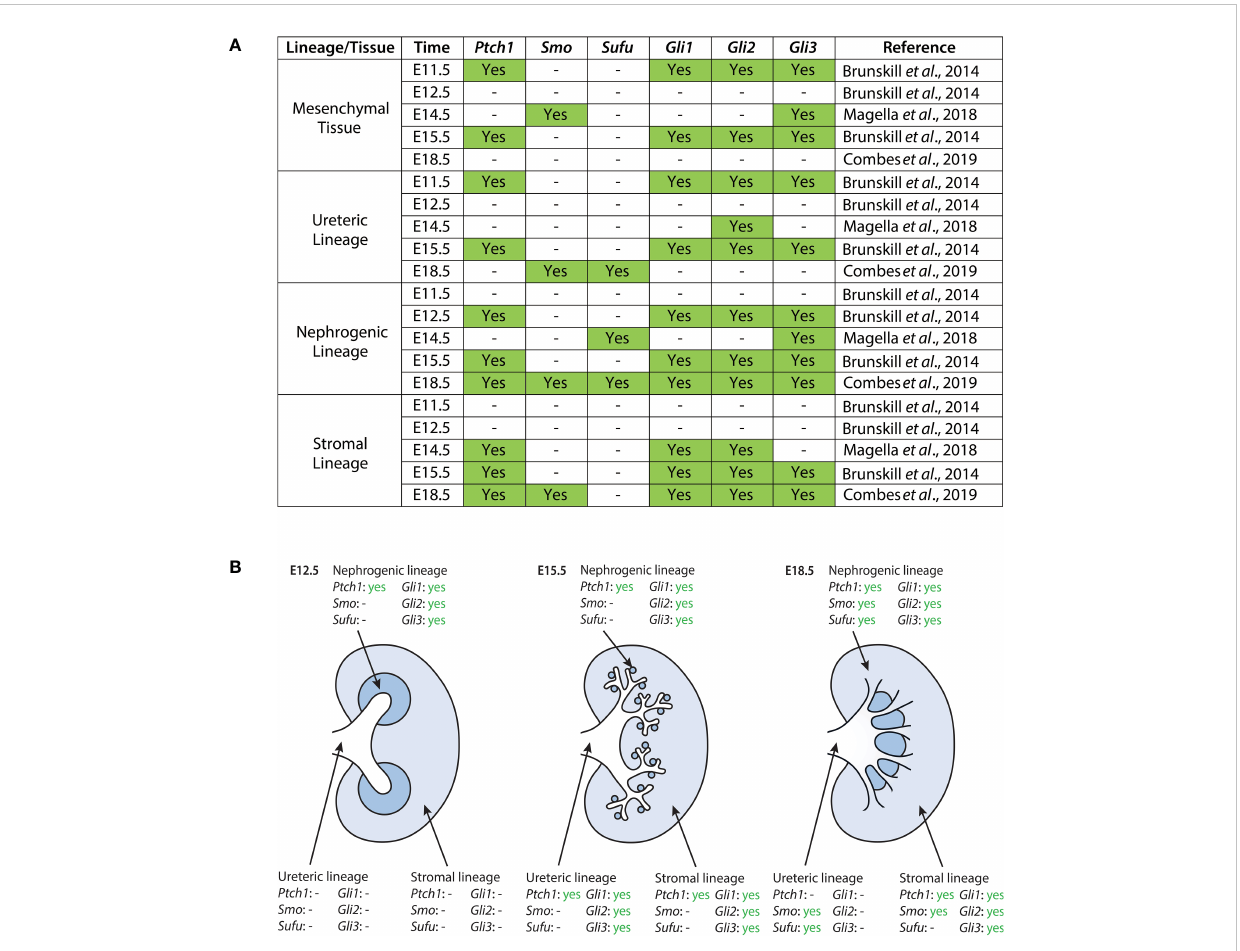
FIGURE 1 Expression of Hh components in the developing mouse kidney as reported in published single-cell RNA sequencing datasets (40, 41, 46). (A) Datasets were screened for expression of Ptch1 , Smo , Sufu , Gli1 , Gli2 , and Gli3 . Expression here is reported as binary; “ yes ” indicates statistically signi fi cant expression of a gene, as determined by the study. The exception to this is the dataset from Magella et al. (E14.5), which reports a cluster of greatest correlation for each gene; here, we include correlations based on both the Fluidigm and Chromium platforms, as they are the ones used by Brunskill et al. and Combes et al., respectively. A dash indicates either no statistically signi fi cant expression of a gene within a lineage cluster, or the absence of expression data reported altogether. (B) Expression of Hh pathway components in the developing mouse kidney at E12.5, E15.5, and E18.5. Data shown here is provided in greater detail in (A)